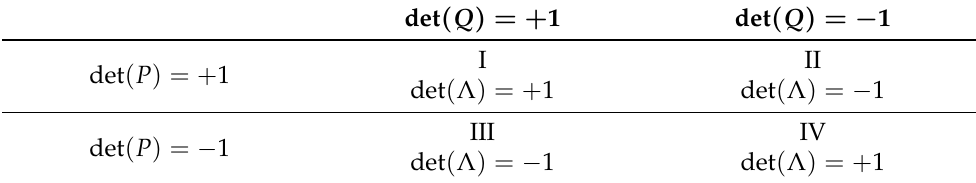
Table 1. Topologically disconnected components I, II, III, and IV of the indefinite orthogonal group O ( r , d − r , R ) . The other sectors can be written as elements of I combined with reflections Λ = diag ( P , Q ) , as described in the text. In the complexified group O ( r , d − r , C ) region I and IV are connected, as well as II and III, but the two sectors with det ( Λ ) = ± 1 remain disconnected from each other.